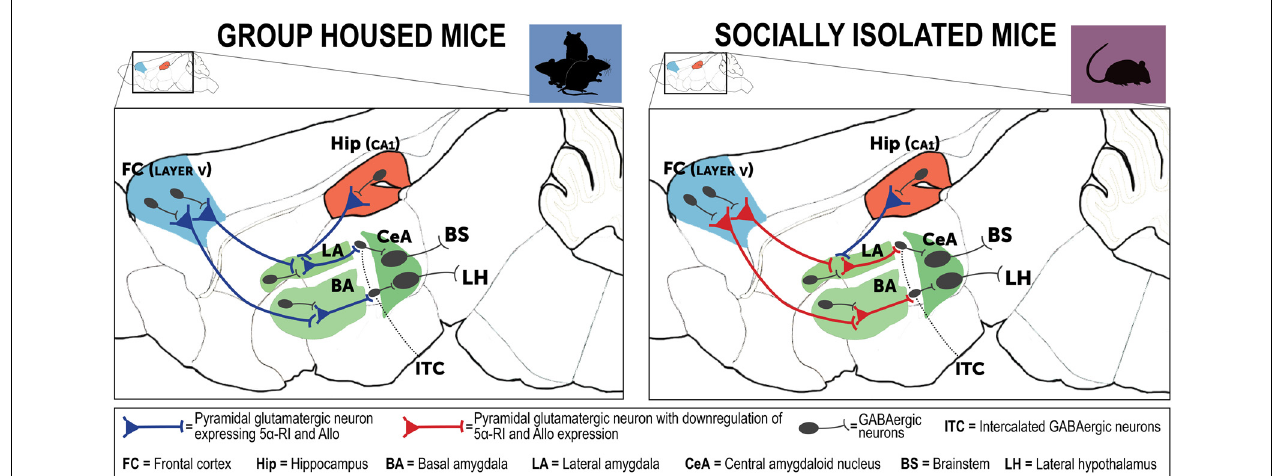
FIGURE 3 | Neurocircuitry underlying the PTSD-like phenotype expressed by socially isolated mice. This is a simplified schematic representation of mouse brain neurocircuitry regulating emotional behavior under physiological (group-housed) and stress-induced deficits (social isolation). The prefrontal cortex and hippocampus directly project to the amygdaloid nuclei to regulate their hyperactivity following traumatic events (Herry et al., 2008). In susceptible individuals, a stressful experience is associated with impairment of cortical inhibitory activity directed to the amygdala, which results in exaggerated hyperactivity and inappropriate fear responses (Akirav and Maroun, 2007; Raber et al., 2019). In PTSD, amygdala hyperactivity is part of a maladaptive emotional processing resulting from exposure to traumatic events. The neural substrates of these behavioral deficits may result from decreased GABA release (downregulated allopregnanolone concentrations (Rasmusson et al., 2006, 2019), in participation with changes in GABA A receptor subunit subtypes (Geuze et al., 2008). Collectively, these neurobiological alterations may explain emergence of PTSD symptoms (Pinna, 2018). In the socially isolated mice, a stress-induced model of PTSD-like behavioral traits, cortical and hippocampal projections directed to the basolateral amygdala (BLA) show a downregulation of allopregnanolone biosynthesis and behavioral correlates, including increased fear responses and impairment of fear extinction (Agís-Balboa et al., 2007; Pinna et al., 2009). In socially isolated mice ( right panel ), allopregnanolone downregulation in cortical and hippocampus pyramidal glutamatergic neurons and in pyramidal-like neurons of the BLA may represent the molecular underpinnings that recapitulate an increased excitability of the neuronal pathway that converges to the intercalated GABAergic neurons (ITC) and central amygdala (CeA) GABAergic spiny neurons (Agís-Balboa et al., 2007; Pinna et al., 2008). Collectively, reduction of allopregnanolone biosynthesis in corticolimbic glutamatergic neurons may impair cortico-hippocampal-amygdaloid circuits by inhibiting the GABAergic output neurons of the CeA, which project to the hypothalamus and brainstem and may explain the excessive fear responses and other behavioral deficits observed in socially isolated mice (Pinna et al., 2008, 2009). Allo, allopregnanolone; 5 α -RI, 5 α -reductase type